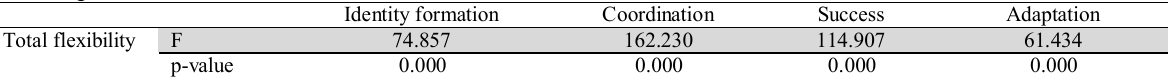
The results of analysis of variance between flexibility and dimensions of human resource development Identity formation Coordination Success Adaptation Total flexibility F 74.857 162.230 114.907 61.434 p-value 0.000 0.000 0.000 0.000